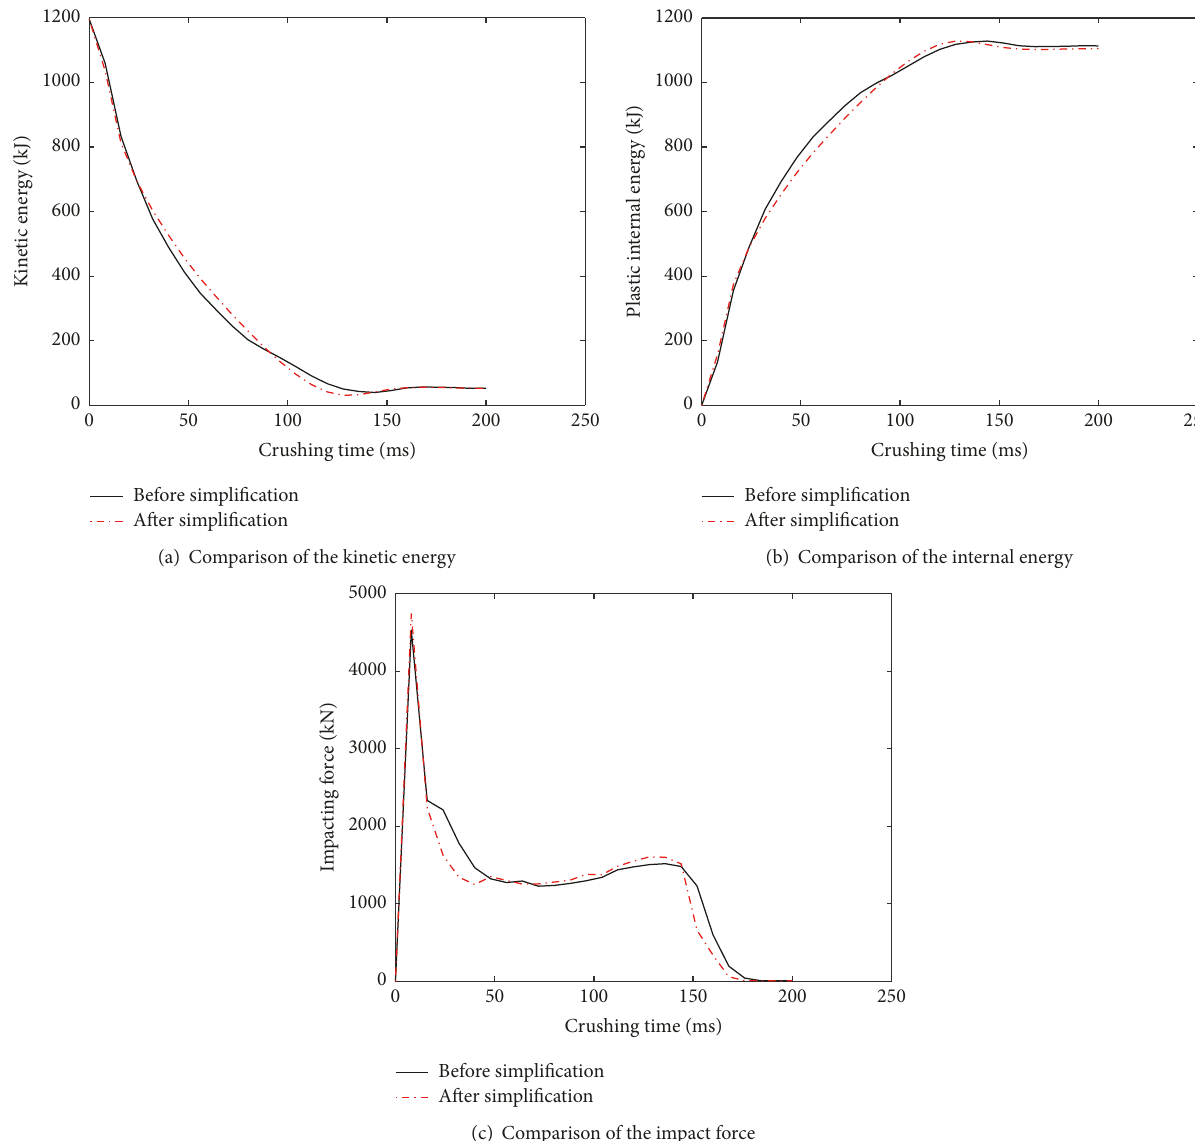
Figure 3: Comparative analysis of the collision data (intermediate vehicle) before, and after, simplification.